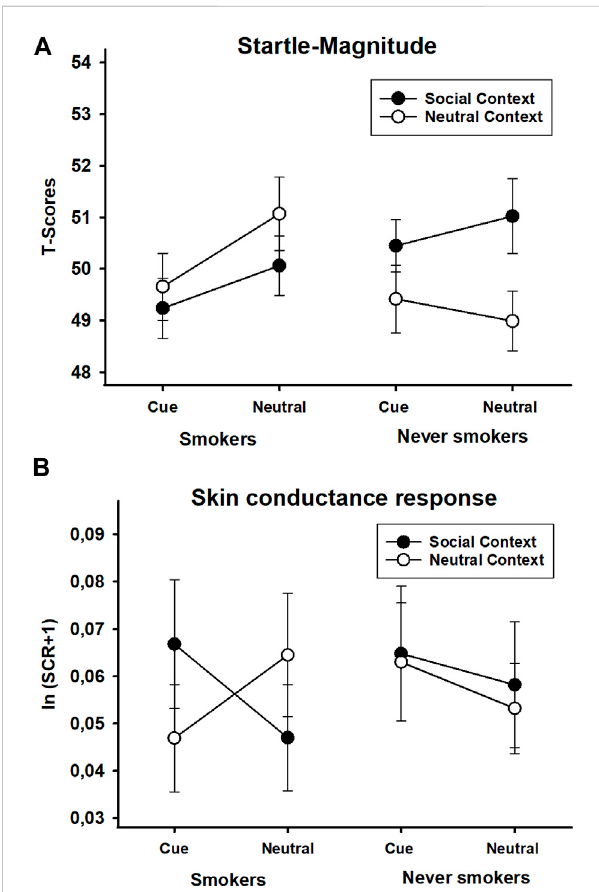
FIGURE 6 Startlemagnitude(T-scores) (A) andskinconductanceresponses [ln (SCR+1)] (B) during smoking and neutral stimuli presented in a social or neutral context in smokers and never-smokers. Error bars represent standard errors of the